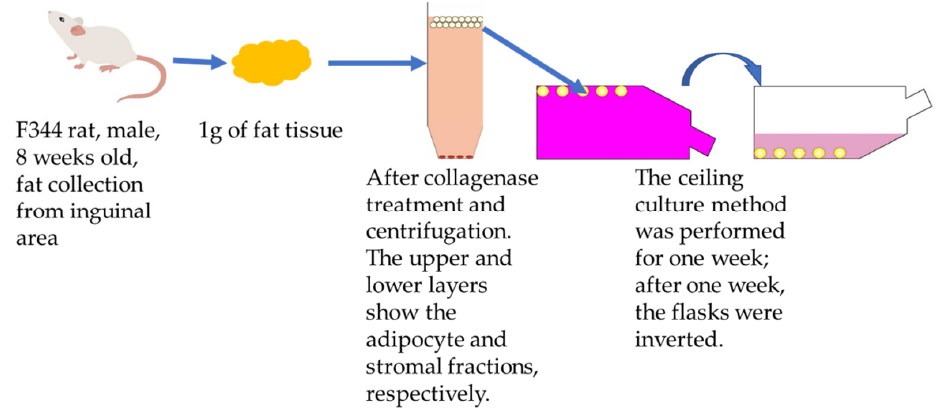
Figure 3. Procedure for creating DFAT cells.